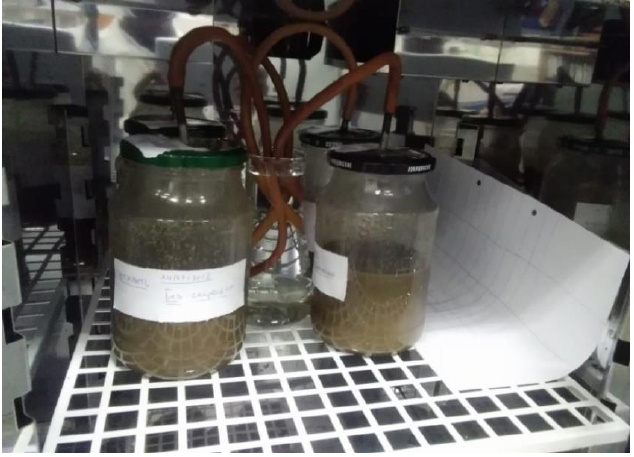
Figure 2. The hand-made fermenters with pipes in the incubator during fermentation.